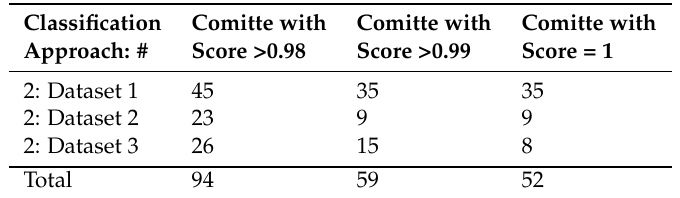
Table 7. Total Number of Machines According to the Score of Approach